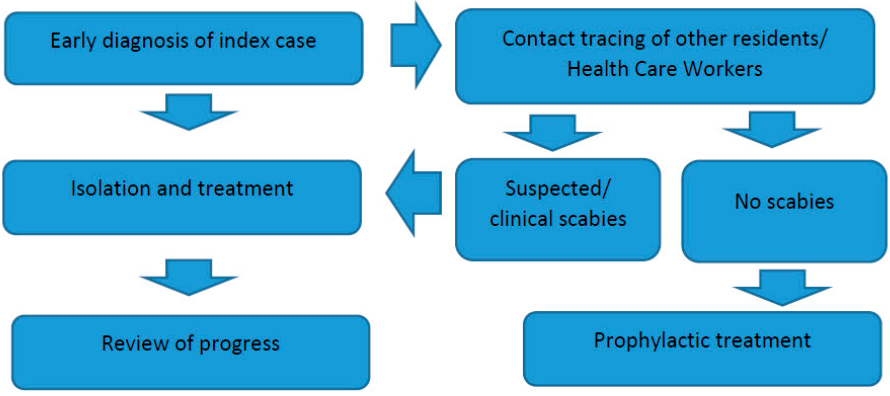
Figure 1. Workflow for management of scabies in long term care facilities.